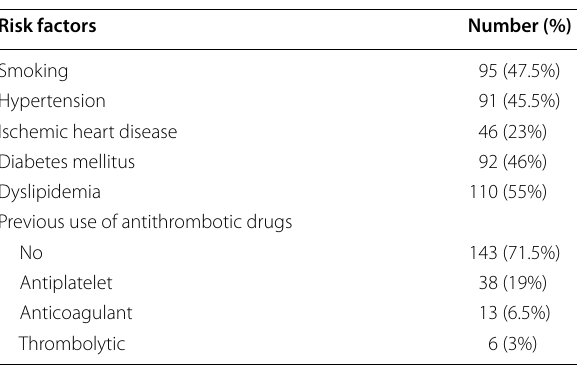
Table 2 Risk factors among ischemic stroke